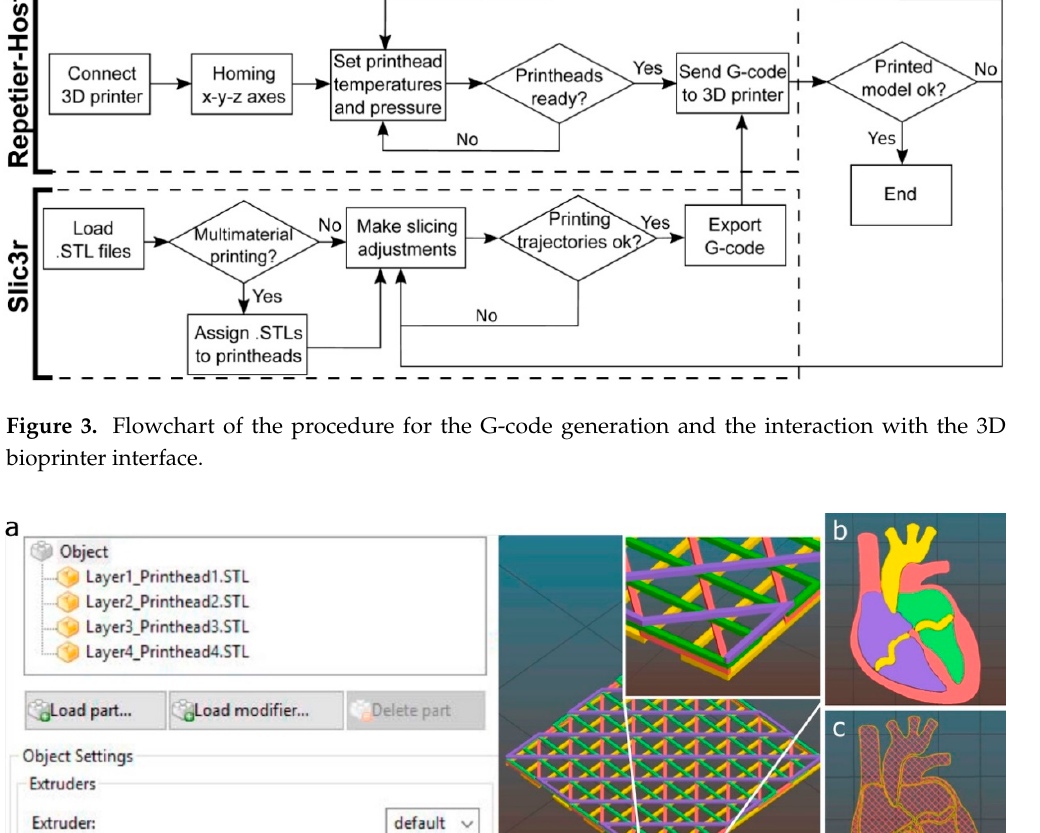
Figure 4. Multi-material printheads assignment using Slic3r software. ( a ) porous structure with four layers stacked, each one assigned to a different printhead; ( b ) 3D model of a heart section composed of four parts; ( c ) printhead trajectories calculated by the slicing software using a porous infill.